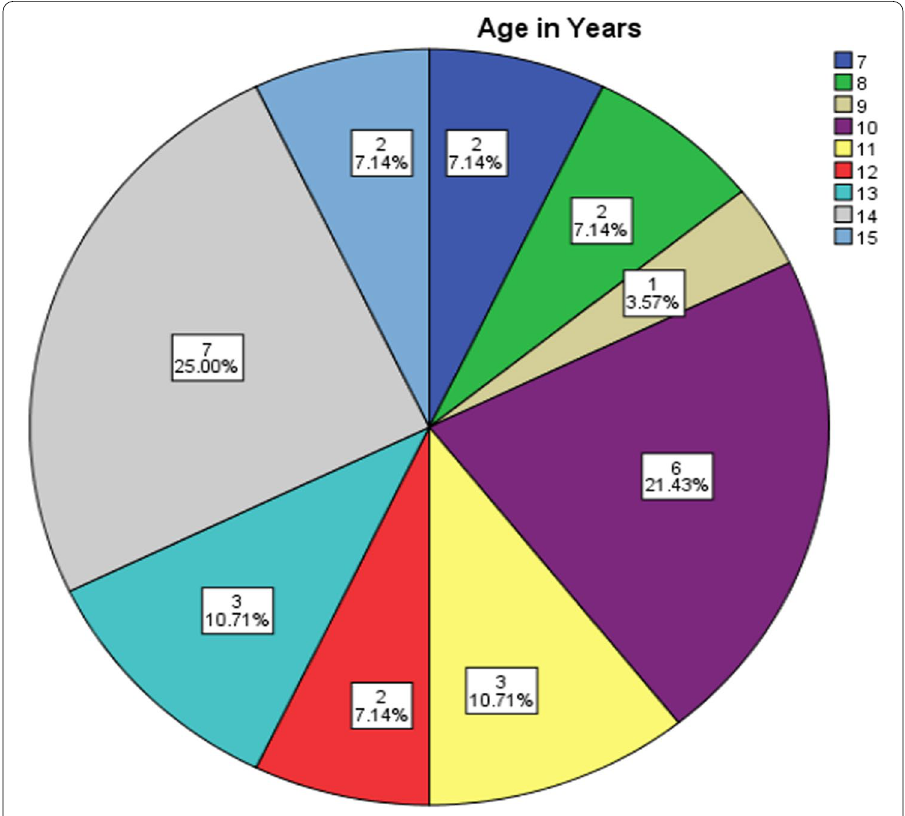
Fig. 2 Age. Source: SPSS 23.0